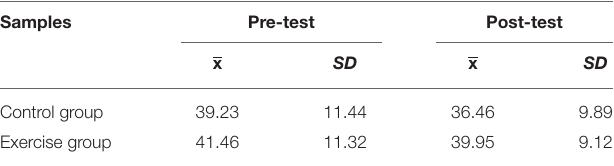
TABLE 3 | Descriptive statistics of anxiety at pre- and the post-test for the total sample and by group. Samples